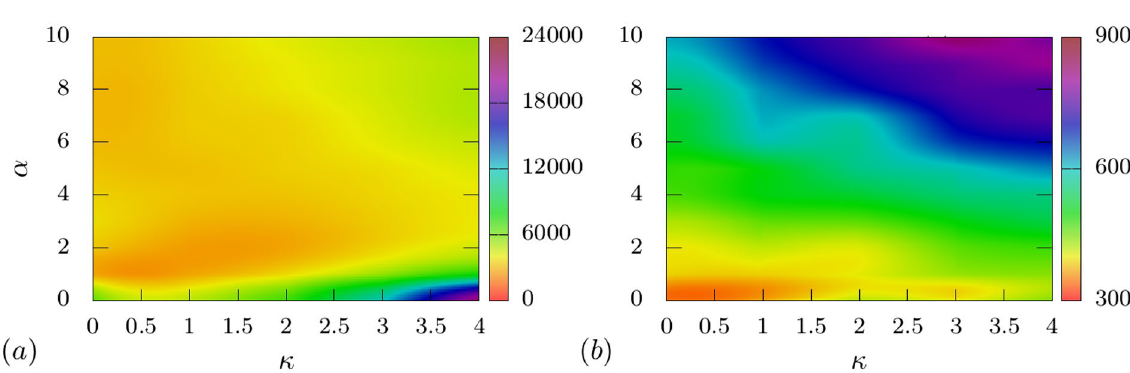
Figure 10. Translocation time ( τ ) as a function of apex angle ( α ) separated into passage time ( τ p ) and escape time ( τ e ) components for two different values of rigidity of the polymer ( a ) κ = 2 and ( b ) κ = 4 for f 0 = 0.2 .